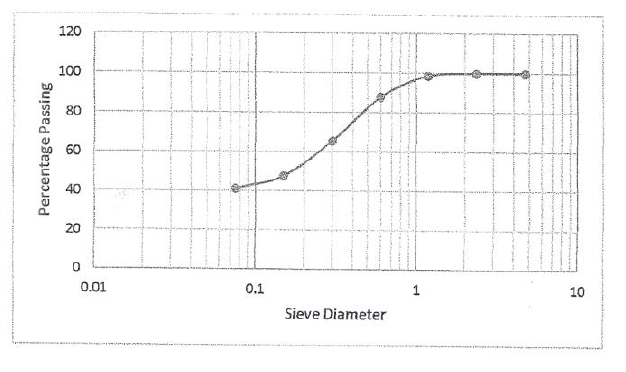
Figure 3: Particle Size Distribution Chart for Point 3